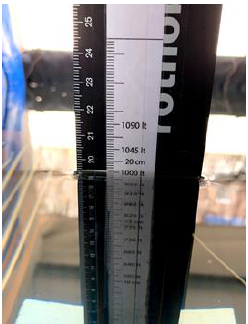
Figure 4. Measurement of volume of evaporated water.